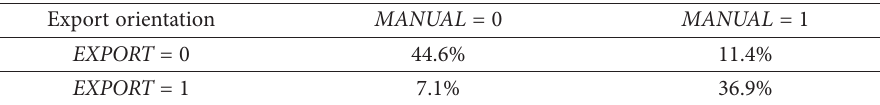
Table 5. Comparison of the model predicting business export orientation from manually retrieved WWW features to the actual export orientation of the firm Export